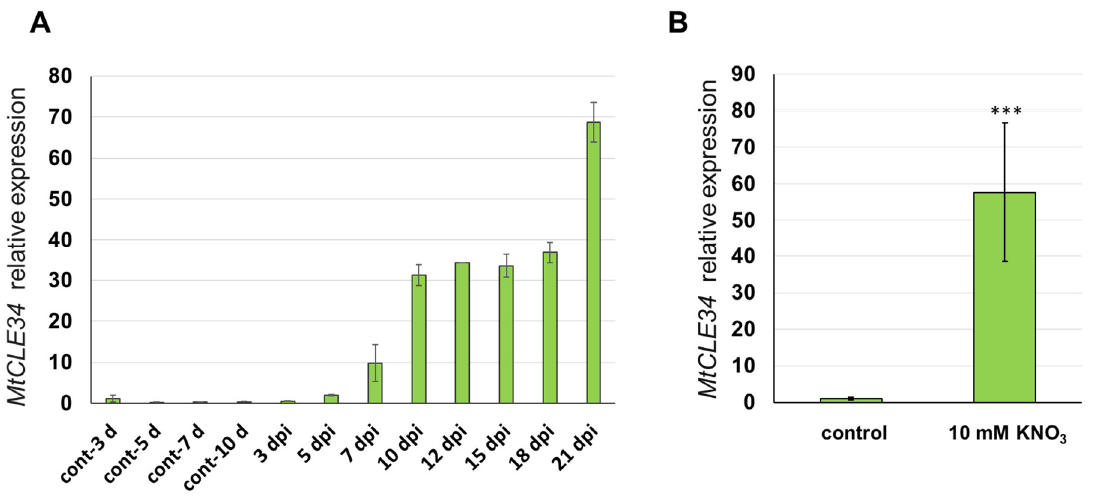
Figure 1. ( A ) The expression levels of the MtCLE34 gene at different timepoints after rhizobial inoculation (days post inoculation, dpi) in comparison to the non-inoculated control roots (cont) in the A17 line. Results are mean ± standard error of the mean (SEM) of three technical repeats of one biological repeat, representative for three independent experiments. ( B ) The expression levels of MtCLE34 in response to nitrate treatment (10 mM KNO3) in the A17 line. *** indicates statistically significant differences in MtCLE34 expression compared with control ( p < 0.001).